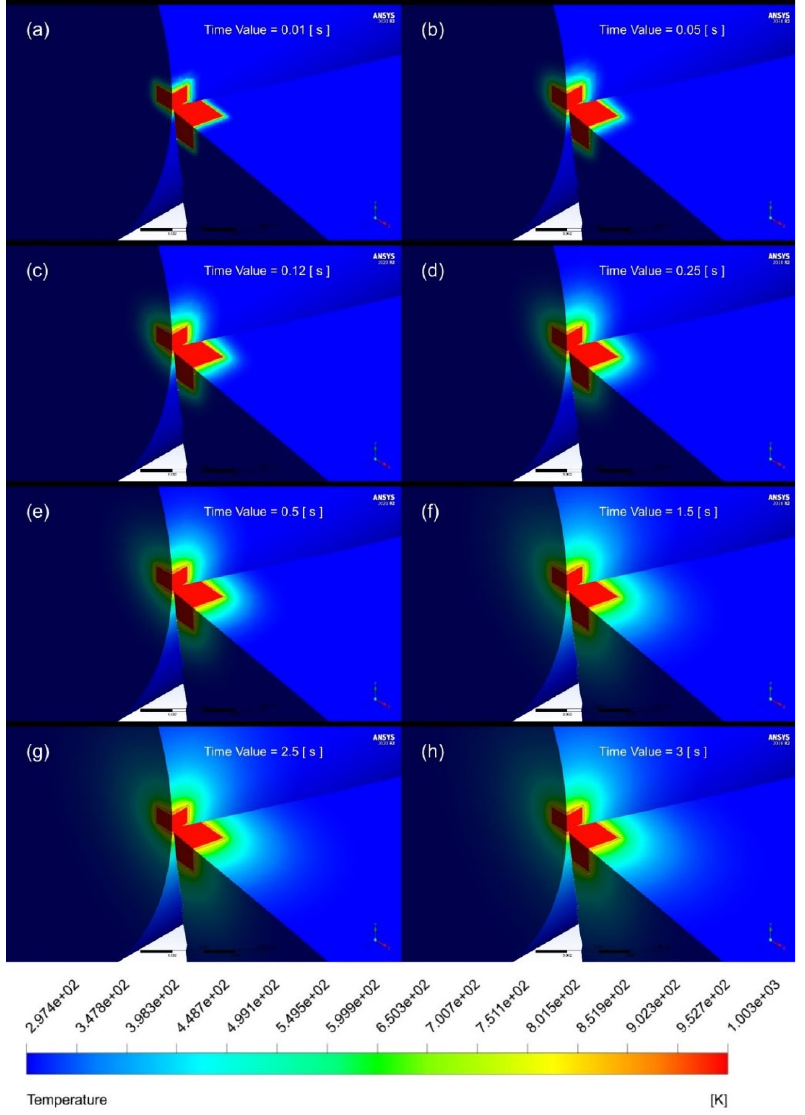
Figure 7. Temperature distribution at the cutting tool–workpiece interface using mineral oil at time ( a ) 0.01 sec, ( b ) 0.05 s, ( c ) 0.12 s, ( d ) 0.25 s, ( e ) 0.5 s, ( f ) 1.5 s, ( g ) 2.5 s and ( h ) 3 s.